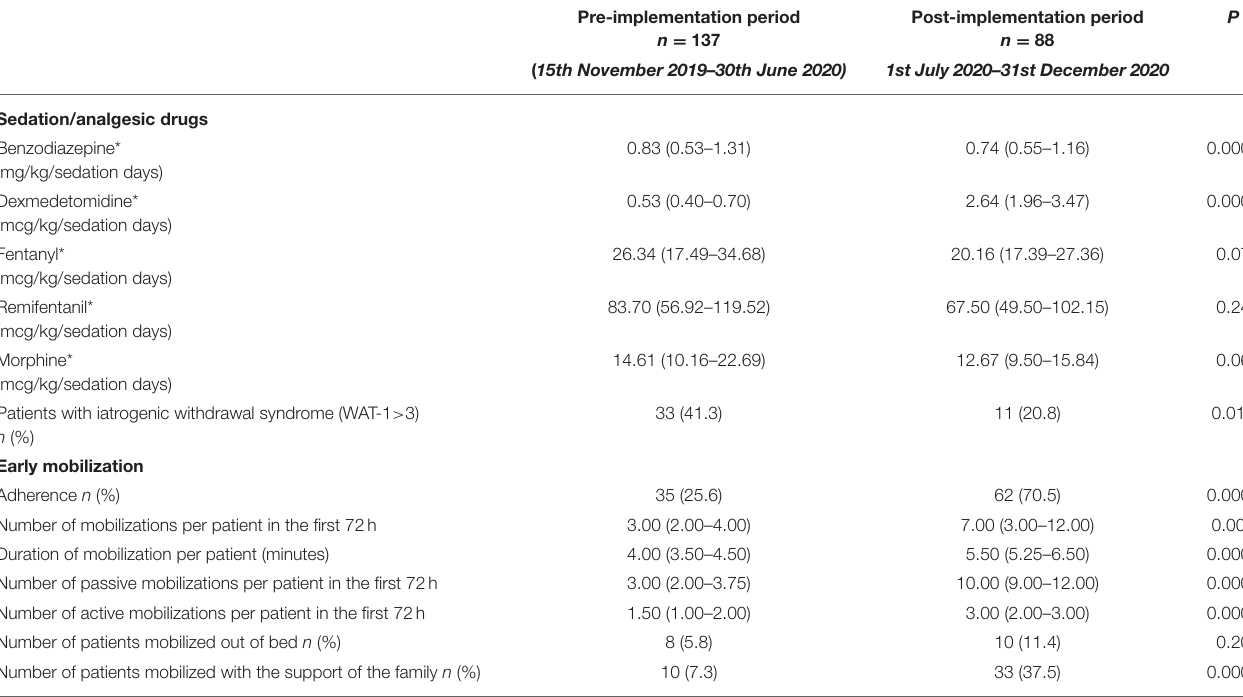
TABLE 2 | Descriptive analysis of sedation/analgesia and early mobilization practices between the pre-post implementation